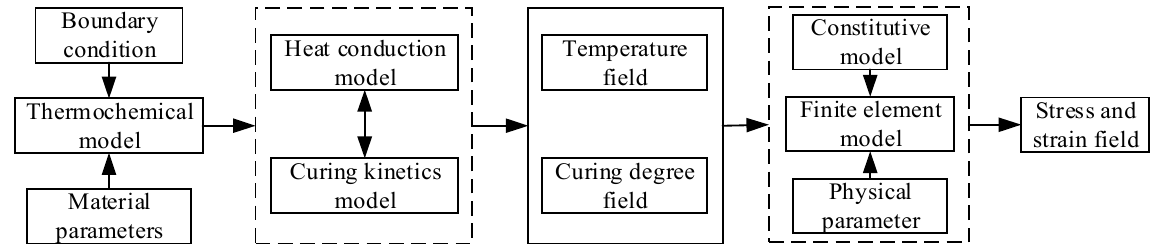
Figure 1. Calculation diagram of numerical simulation. Based on the kinetic equation of the curing reaction, the constitutive mechanical model and the heat transfer equation, the 3D SRM grain model can be introduced into the user- defined heat release (HETVAL) to simulate the chemical evolution process of the curing, and the curing degree can be obtained. Combined with the user-defined material expansion (UEXPAN), user-defined material mechanical behavior (UMAT), and user-defined field (USDFLD) subroutines, the model can be put into material modulus changes and cure shrinkage, which is capable of calculating the curing degree, deformation, and residual stress of propellant grain [26].